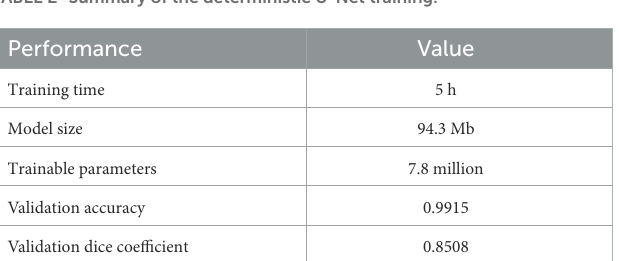
TABLE 2 Summary of the deterministic U-Net training.